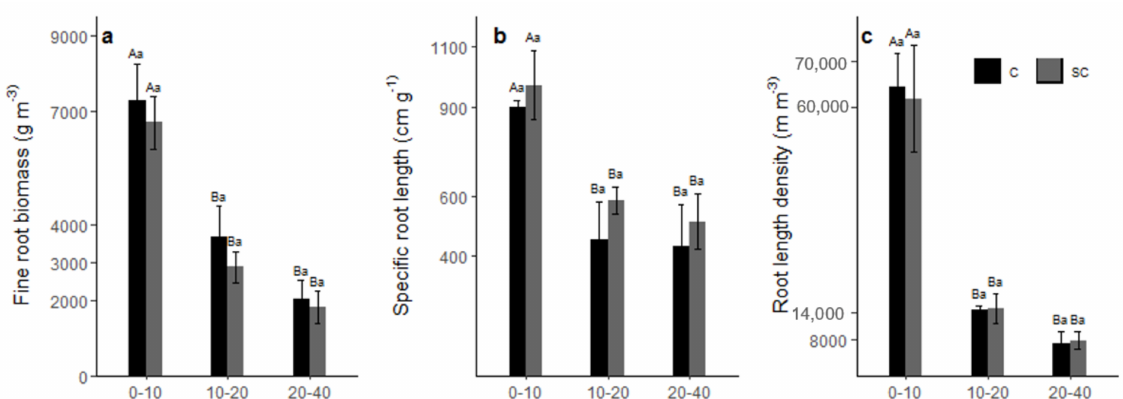
Figure 3. ( a ) Fine root biomass, ( b ) specific root length, and ( c ) root length density in two treatment plots (strip clearcutting (SC) and unharvested (C)). Error bars indicate the standard deviation ( n = 3). Capital letters indicate the difference in fine root characteristics between different soil layers under the same treatment ( p < 0.05); lowercase letters indicate differences in fine root characteristics between treatments in the same soil layer ( p <